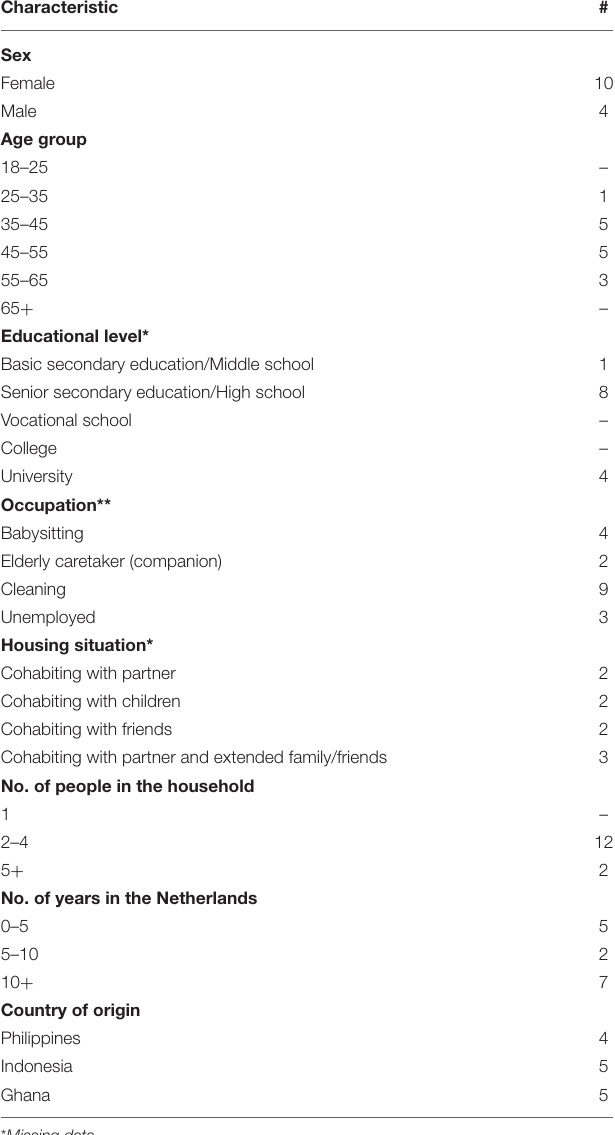
TABLE 1 | Characteristics of